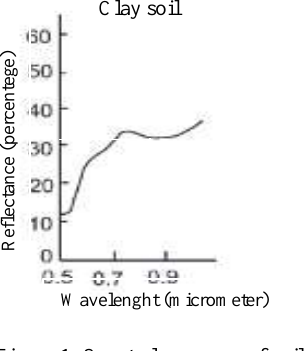
Table 1 - Central wavelenghts and their FWHM for 50 cm